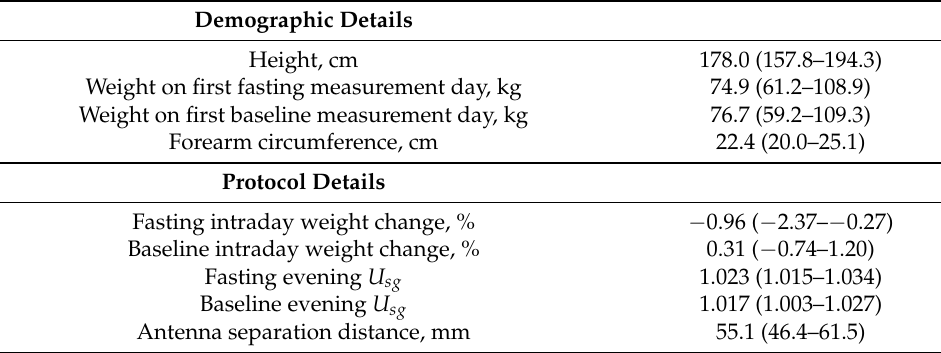
Table 1. Summary of volunteer details for fasting